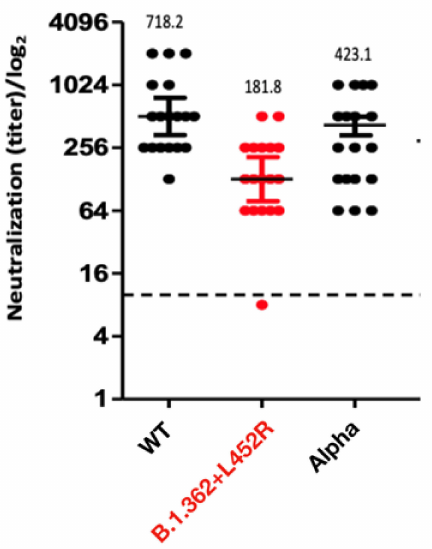
Figure 3. Neutralization capacity of the B.1.362+L452R variant. Neutralization assays were carried out with VERO-E6 cells infected with the B.1.362+L452R variant, the Alpha variant and a local WT strain, using sera from individuals obtained at least 30 days following the second dose of the Pfizer-BioNTech vaccine. Bars represent the log geometric mean titer (GMT) and 95% confidence intervals. A dilution equal to 1:10 or above was considered neutralizing (dashed